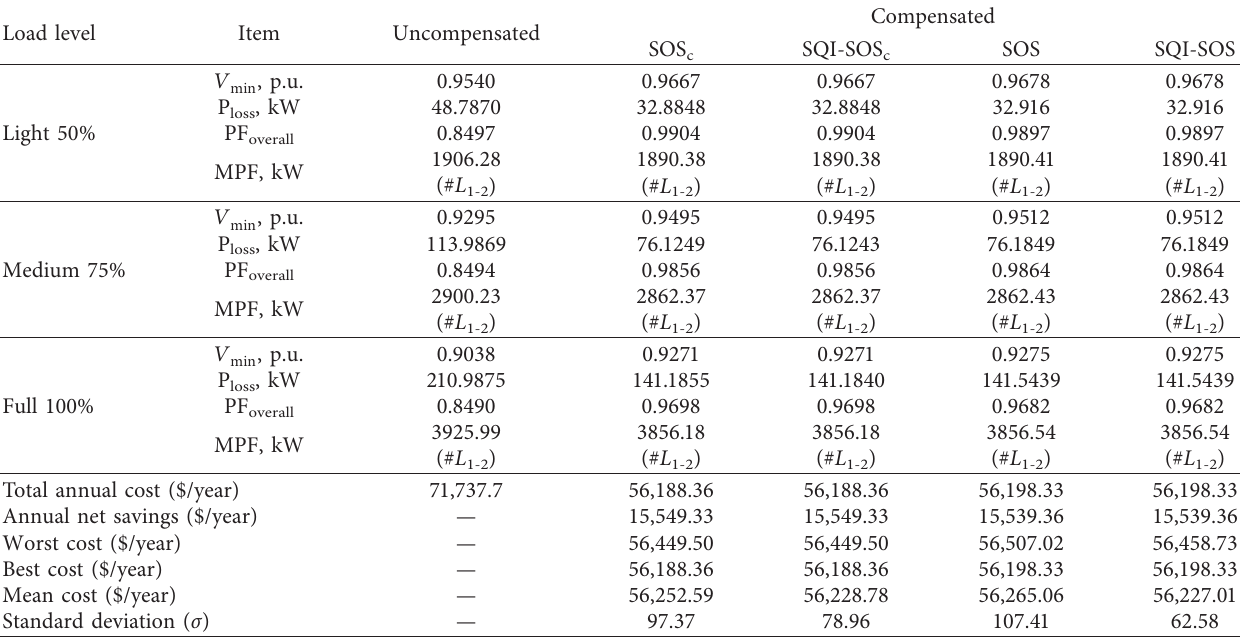
Table 5: Comparison results of the 33-bus system before and after compensation with the CP load model at different load levels. Load